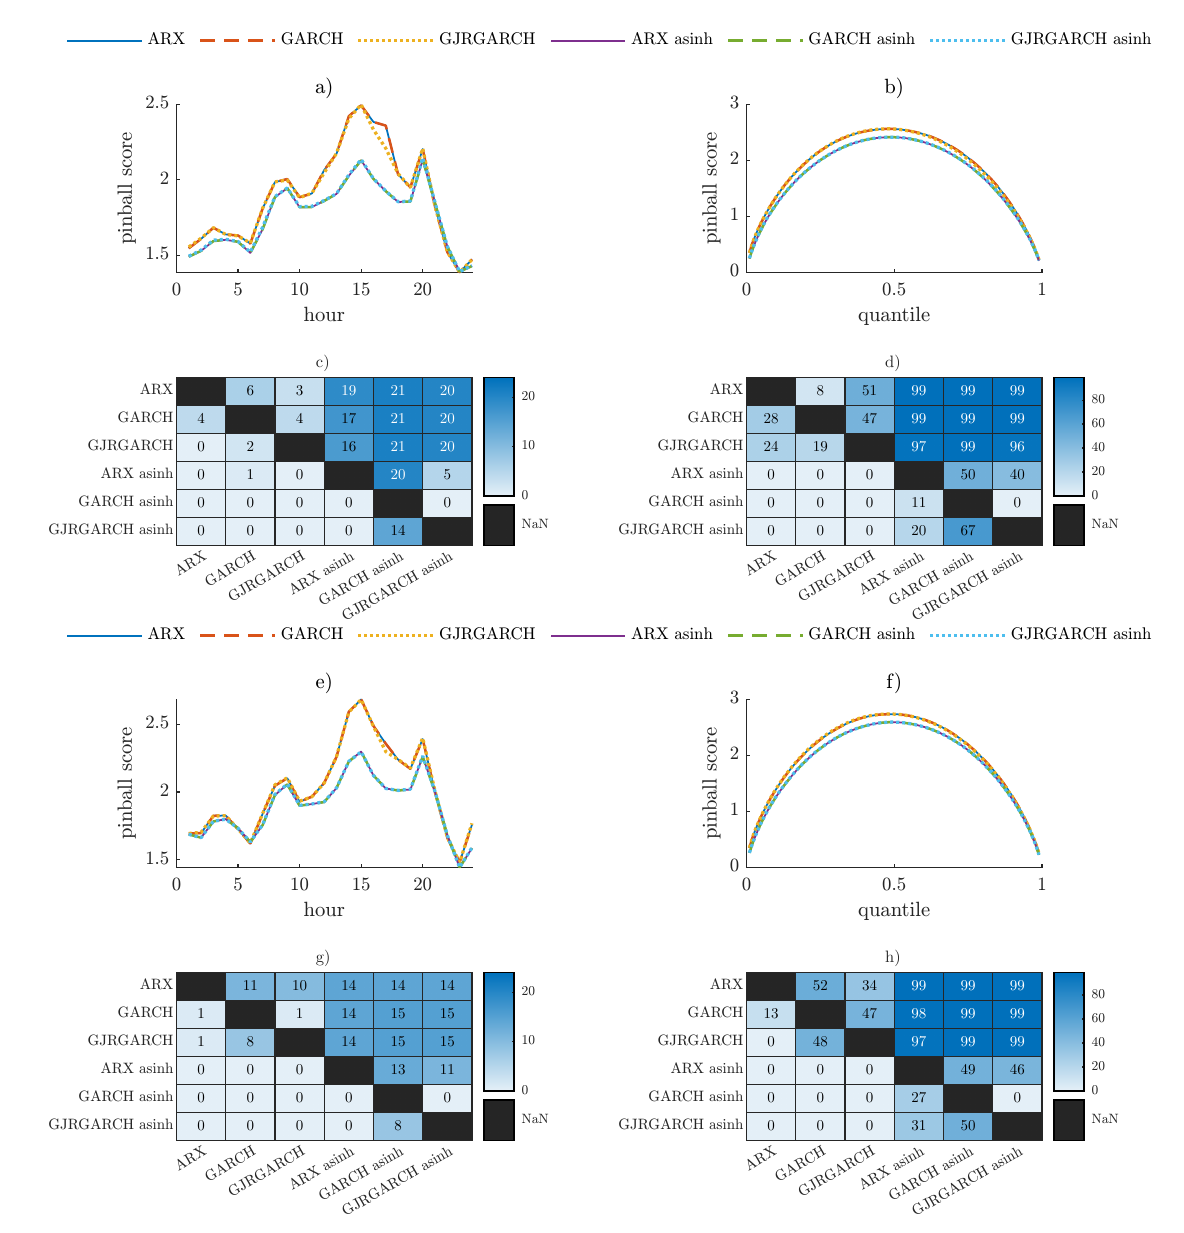
Figure 3. Pinball scores obtained for probabilistic forecasts of the German day-ahead (panels ( a – d )) or intraday (panels ( e – h )) electricity prices obtained using ARX, GARCH and GJRGARCH models with or without asinh transformation. The mean score over all percentiles for each hours is plotted in the left panels (( a )—for day-ahead and ( e )—for intraday), while the mean over hours for each quantile in the right panels (( b )—for day-ahead and ( f )—for intraday). The corresponding, aggregated, one- sided Diebold–Mariano test results are given in the corresponding bottom panels ( c , d , g , h ). Source: Authors’